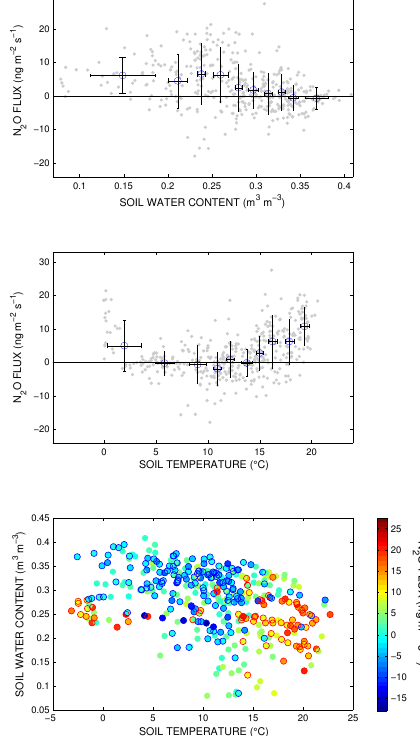
Figure 5. N 2 O daily average fluxes (grey dots) versus soil water content and soil temperature. Blue circles in the upper two panels show bin averages (40 days per bin), with error bars representing the standard deviation within each bin. In the lower panel, fluxes <0ngm − 2 s − 1 are circled in blue, fluxes >9ngm − 2 s − 1 are circled in red. Management events were excluded from the